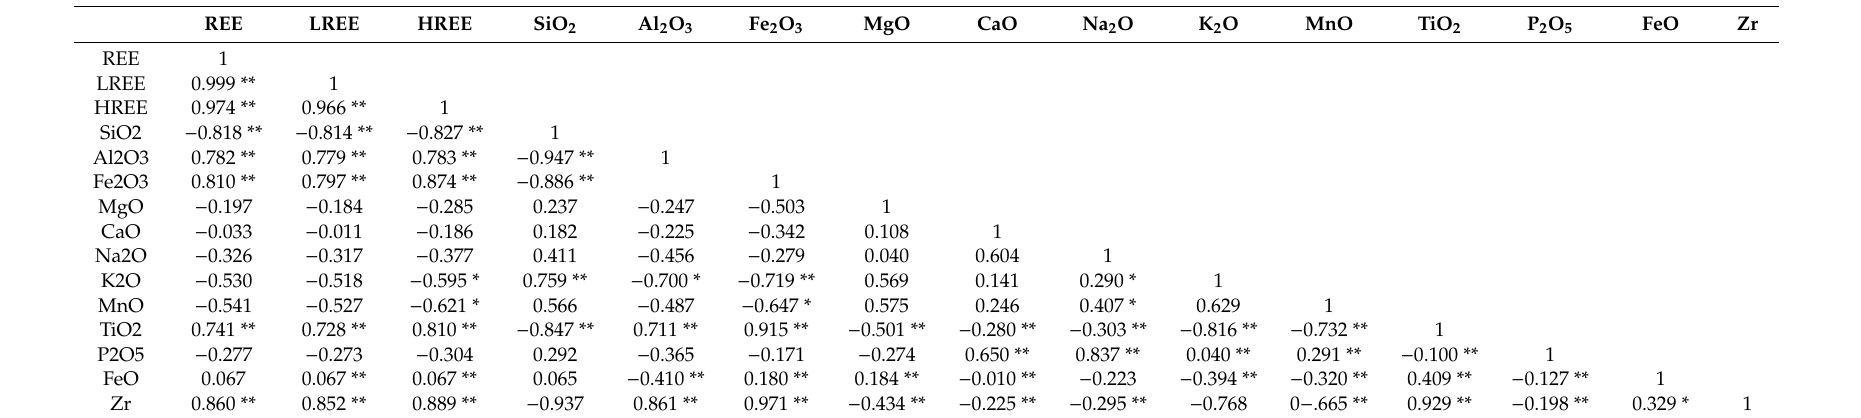
Table 4. Correlation analysis of REE and major